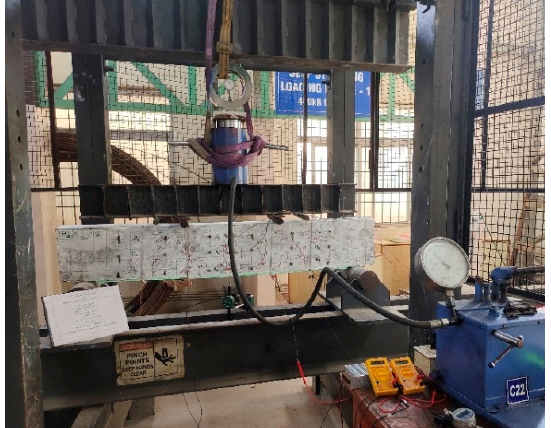
Figure 3. Test setup of the beam with smart mortar layer.